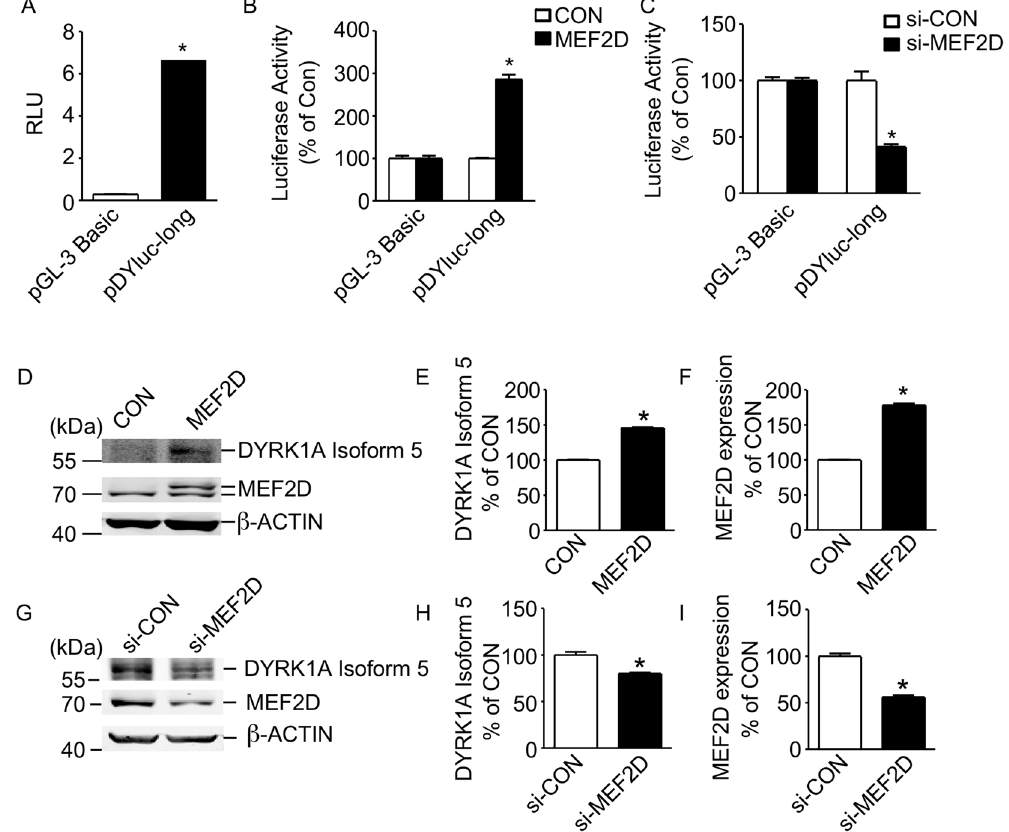
Figure 2. MEF2D specifically activates DYRK1A isoform 5 promoter. ( A ) The DYRK1A promoter construct pDYluc-long, containing the 1825 bp fragment of 5 ′ -UTR from the human DYRK1A isoform 5, was transfected into HEK293 cells. Dual luciferase activity was measured 48h after transfection by a luminometer. The values represent the means ± S.E. (n = 3); * p < 0.01 by Student’s t test. ( B ) MEF2D increases DYRK1A promoter activity. The DYRK1A promoter construct pDYluc-long and pGL-3 basic were co-transfected with MEF2D expression plasmid or empty vector into HEK293 cells. Dual luciferase assay was performed 48 h after transfection. Values represent means ± SEM; n = 3; * P < 0.01 by Student’s t test. ( C ) Knock down of MEF2D leads to decrease of DYRK1A isoform 5 promoter activity compared with control. Dual luciferase assay was performed 48h after transfection. Values represent means ± SEM; n = 3; * P < 0.01 by Student’s t test. ( D – F ) Overexpression of MEF2D increased DYRK1A isoform 5 protein level in T98G cells. pCMV6-entry-MEF2D and empty control vector were transfected into T98G cells. Cells were harvested after 48 hours’ transfection. MEF2D was detected with anti-MEF2D antibody (610774, BD, San Jose, CA, USA). DYRK1A isoform 5 was detected with anti-DYRK1A antibody (ab156818, Abcam, Shanghai, China). β -ACTIN was used as loading control. The values represent the means ± SEM; n = 3; * P < 0.01 by Student’s t test. ( G – I ) The knockdown of si-MEF2D decreased DYRK1A isoform 5 protein level in T98G cells. T98G cells were co-transfected with si-MEF2D and control. Cells were harvested after 48 hours’ transfection. MEF2D was detected with anti-MEF2D antibody. DYRK1A isoform 5 was detected with anti-DYRK1A antibody (ab156818, Abcam, Shanghai, China). β -ACTIN was used as loading control. The values represent the means ± SEM; n = 3; * P < 0.01 by Student’s t